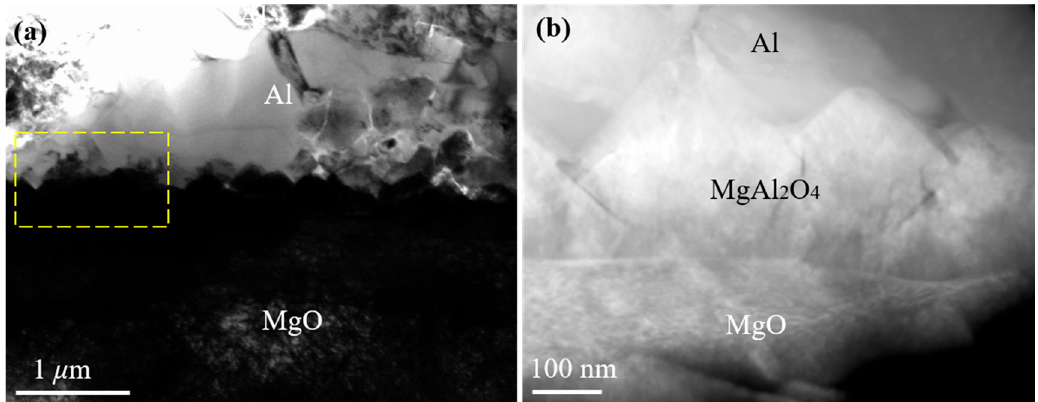
Figure 2. ( a ) A typical cross-sectional transmission electron microscope (TEM) image of the Al / {001} MgO interface. ( b ) A high-angle annular dark-field (HAADF) Z-contrast image of the Al / MgO interface, which corresponds to the frame of (a).